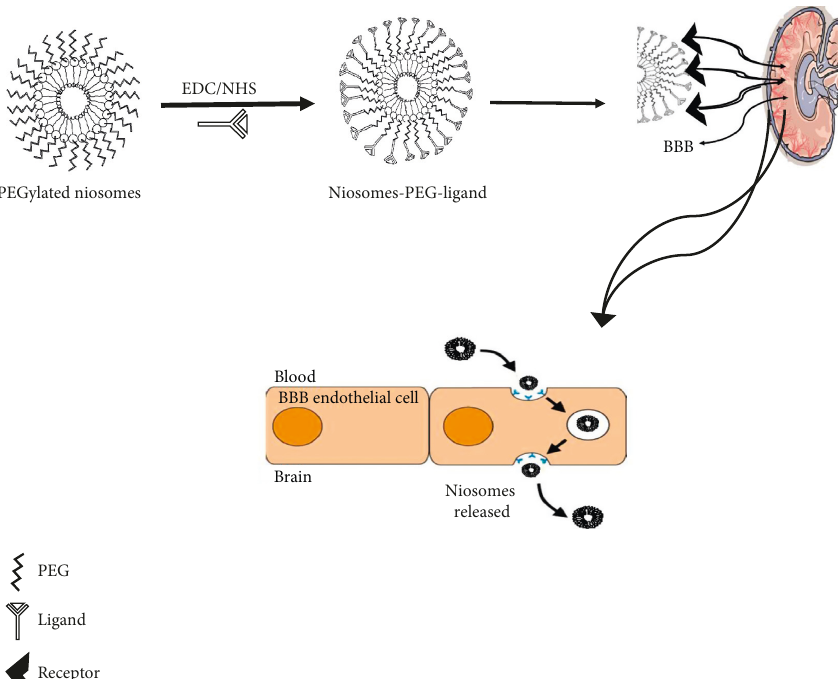
Figure 12: Schematic conjugation of targeting ligand to PEGylated niosomes delivery to